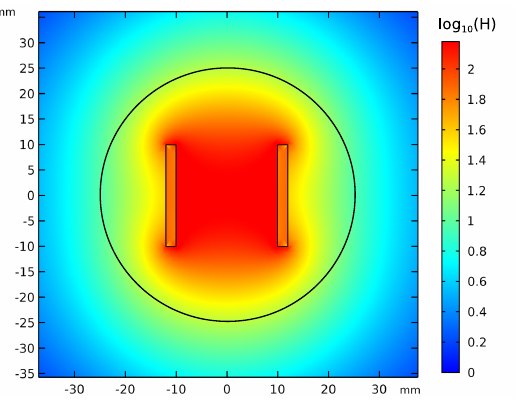
H log . 10 1 A m (cid:18) (cid:19)